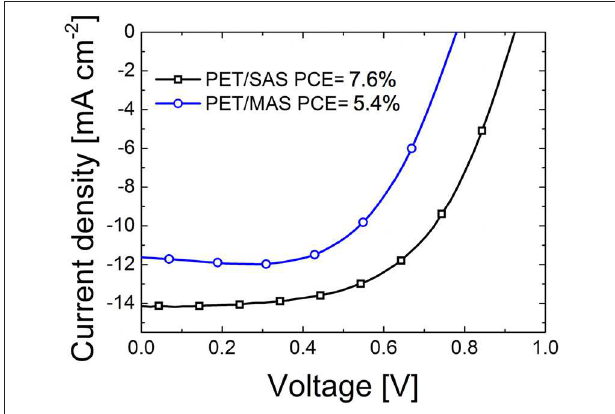
FIGURE 5 | Current-voltage characteristics of flexible perovskite solar cells fabricated on PET/SnO 2 /Au/SnO 2 (SAS) and PET/MoO x /Au/SnO 2 (MAS) electrodes; device structure was completed with a mesoporous-TiO 2 /